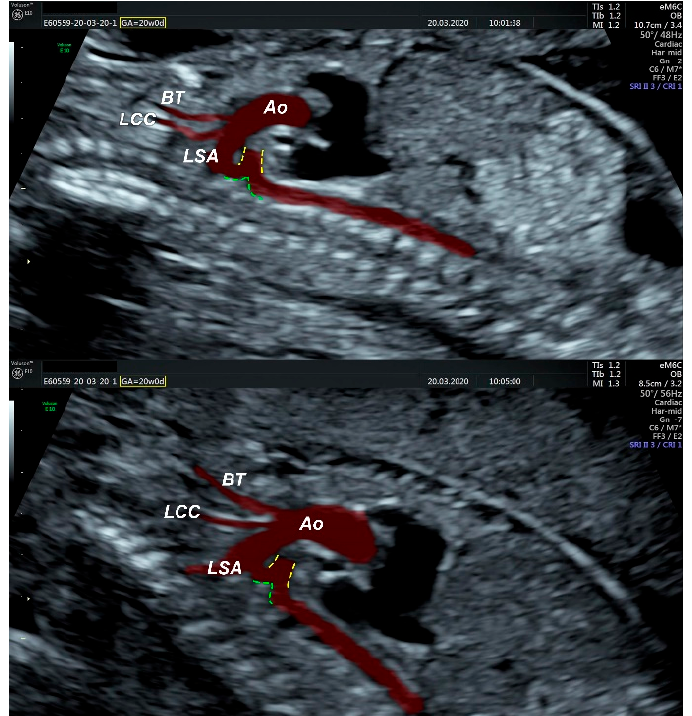
Figure 2. Transversal sections through the fetal mediastinum; Three-vessel view. White arrow—aneurysmal structure located above the emergence of the pulmonary artery; Yellow dashed lines—communication between the aneurysmal structure and either the pulmonary trunk or the left pulmonary artery; PT—pulmonary trunk; Ao—(ascending) Aorta; SVC—superior vena cava.